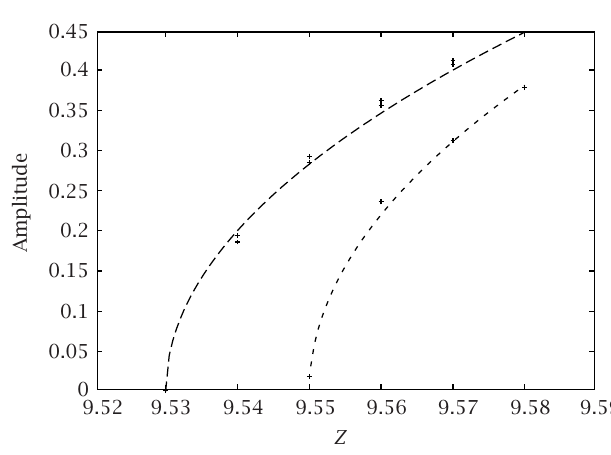
Figure 5.2 . Amplitude of periodic oscillations as a function of Z . Lower crosses: without heat loss; upper crosses: with heat loss in the boundary con- dition and in the equation; and dashed curves: approximation by the square- root